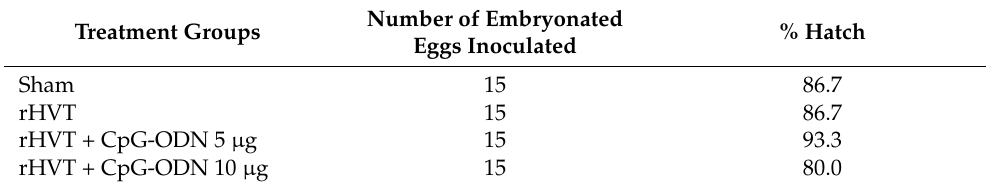
Table 2. Chick hatchability following in ovo administration of vaccine ± CpG-ODN.